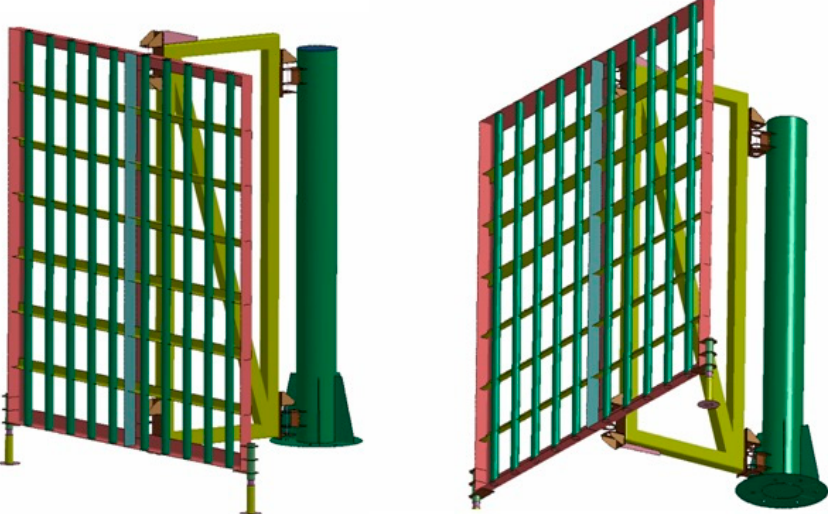
Figure 5. Geometric model of the shield for inflating wheels fitted to a vehicle—general overview.